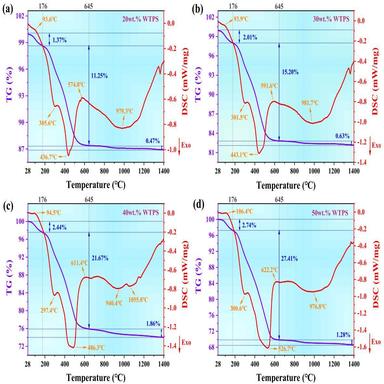
TG-DSC curves of powder mixtures with different WTPS dosages: (a) 20 wt% WTPS, (b) 30 wt% WTPS, (c) 40 wt% WTPS, (d) 50 wt% WTPS.